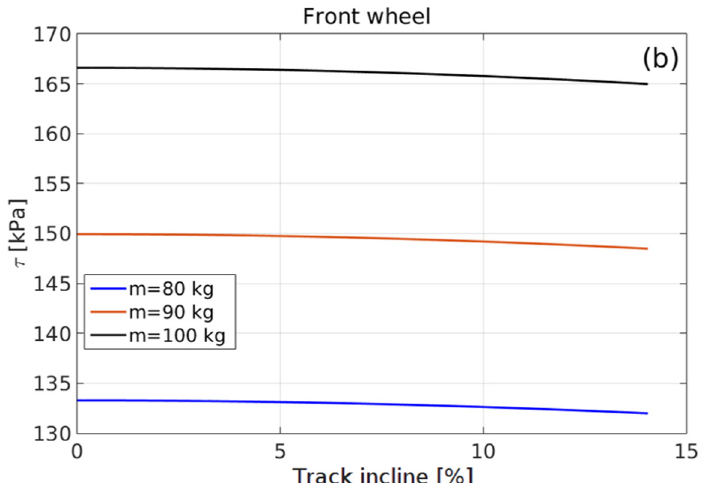
Figure 5. The shear stress applied on the ground surface by the rear ( a ) and front ( b ) wheels as a function of downhill track’s incline and combined mass of biker and bike, when the bike skids. Note: we assume that µ k = 0.5, and that two thirds of total weight are on the rear wheel.